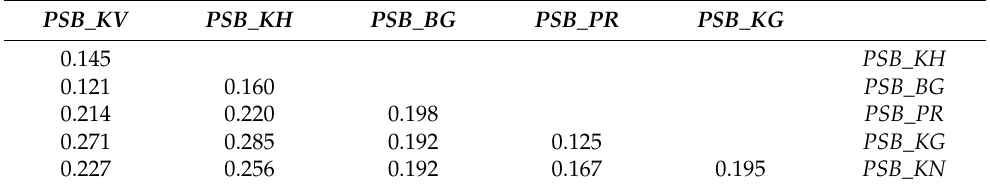
Table 9. Pairwise genetic distances ( D N ) between the populations studied of Pinus sibirica De Tour.